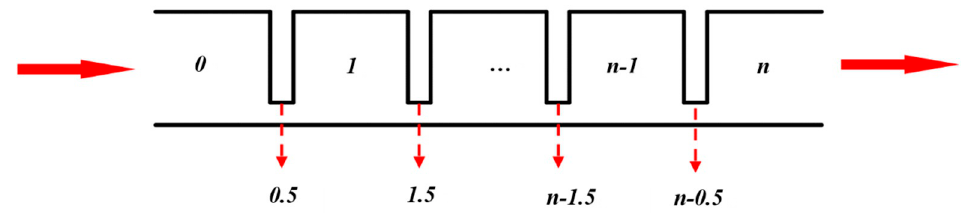
Figure 3. 1-D computation site distribution of labyrinth seal.